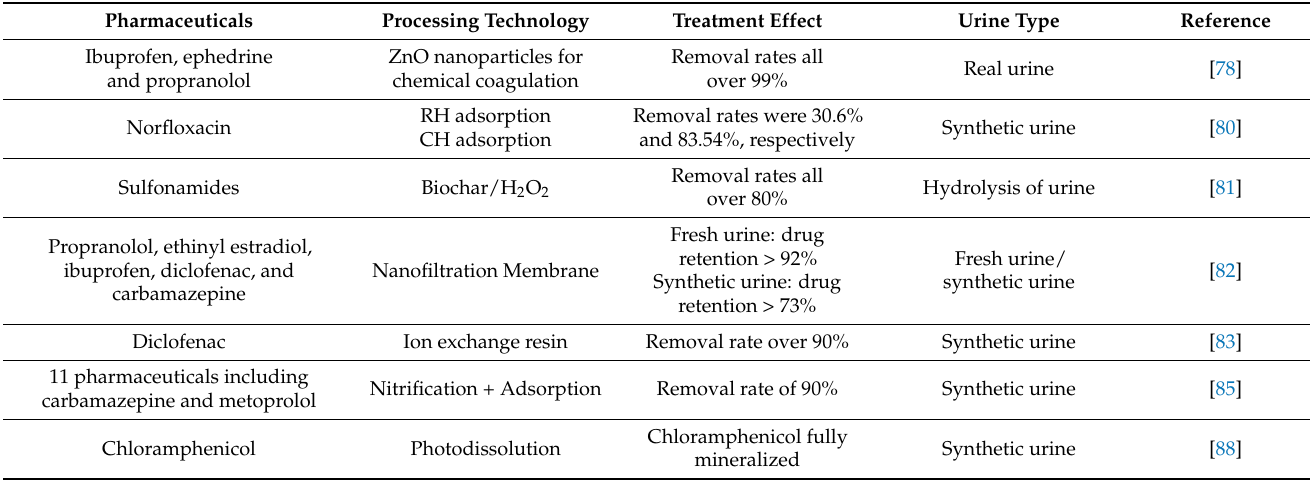
Table 4. Treatment of different pharmaceutical contaminants in